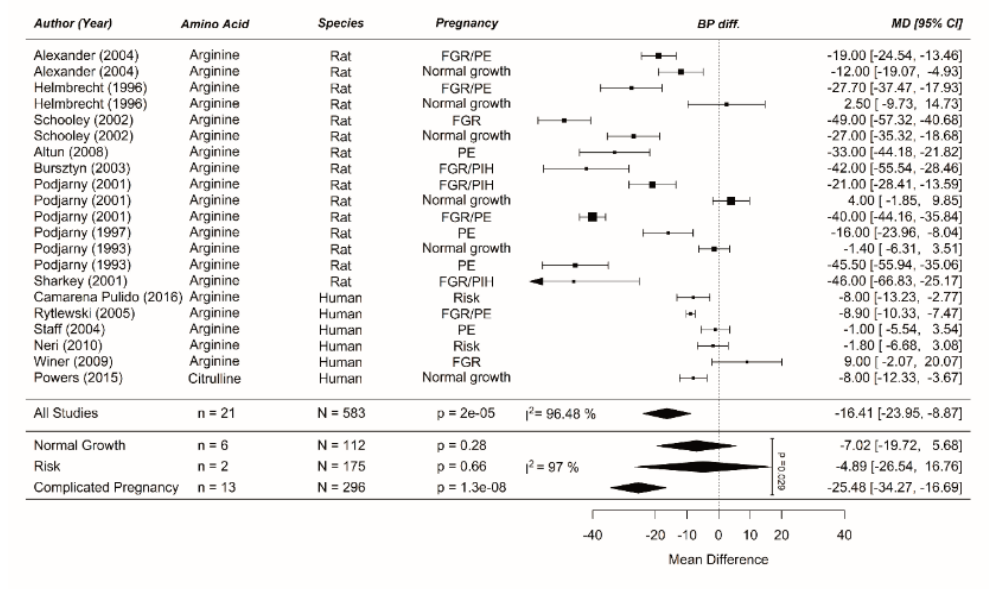
Figure A4. Meta-analysis on prenatal supplementation of arginine on maternal blood pressure. Blood pressure was unaffected in normal growth pregnancies following arginine supplementation, but was reduced in the risk population and complicated pregnancies. The data is ordered within each amino acid (AA) from smallest to largest animal. Blood pressure difference (BP diff) data represent pooled estimates expressed as mean difference (MD) with 95% confidence interval (CI) using a random effect model. Residual is shown. FGR, fetal growth restriction; I 2 , heterogeneity; PE, preeclampsia; PIH, pregnancy-induced hypertension.